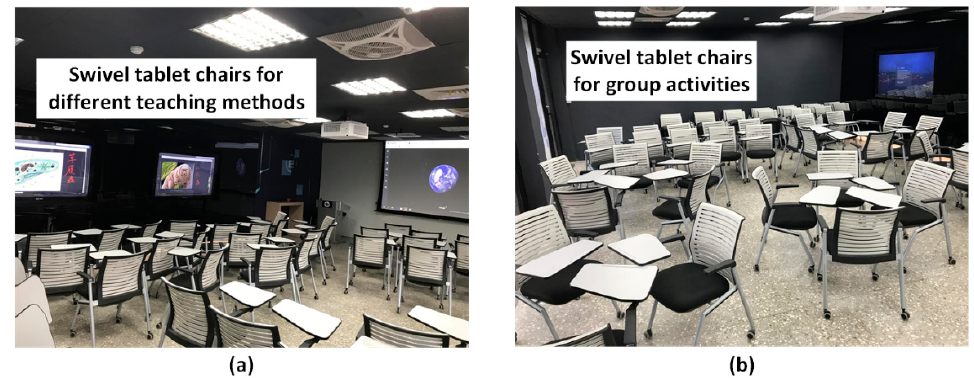
Figure 3. Basic requirements for teaching with digital lecture material: ( a ) A computer installed in the lectern connected to the projector and a multi-touch screen, the input signal goes to both projector and touch screen; ( b ) a wireless microphone for lecturing. Audio speaker play sounds from both the microphone and the computer. 2.1.2. From a Technology-Rich Classroom to a Smart Classroom When a classroom meets the basic requirements listed in the previous subsection, the classroom is ready for most classroom activities, including lectures, discussions, interaction, presentations and debate, supported by technology devices. A technology-rich classroom should have advanced functions or features, such as tele-education, interactive, automation, IoT devices, learning systems, environment control, and classroom management, to be a smart classroom. Technology or equipment needed to achieve smart classroom functions are described as follows: 1.